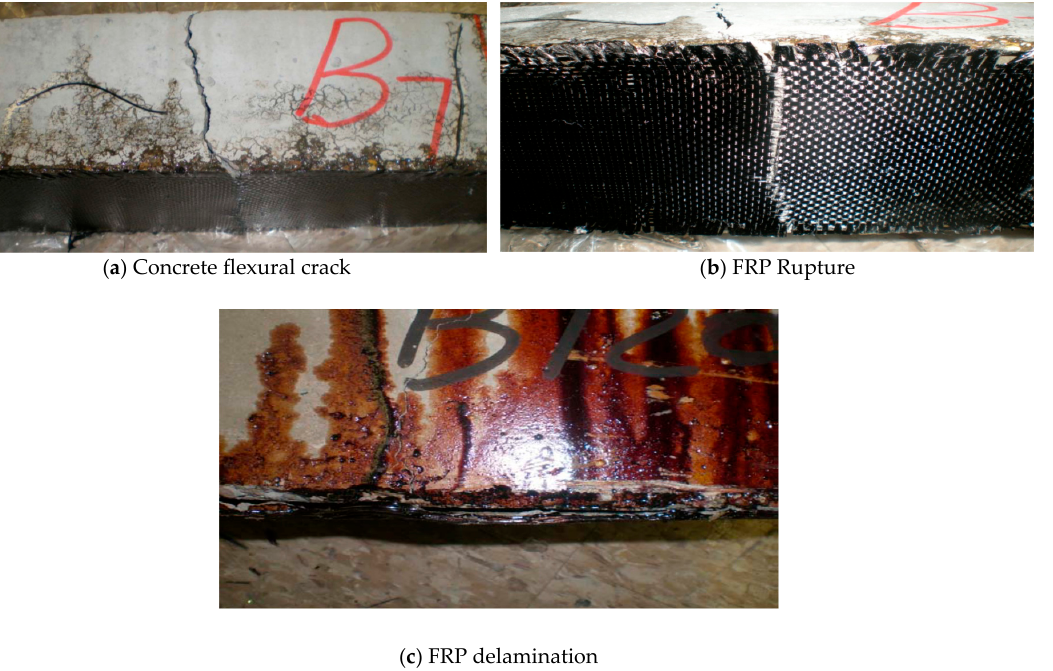
Figure 6. Concrete flexural crack, FRP rupture and delamination at experimental tests. Elarbi, 2011 [2].